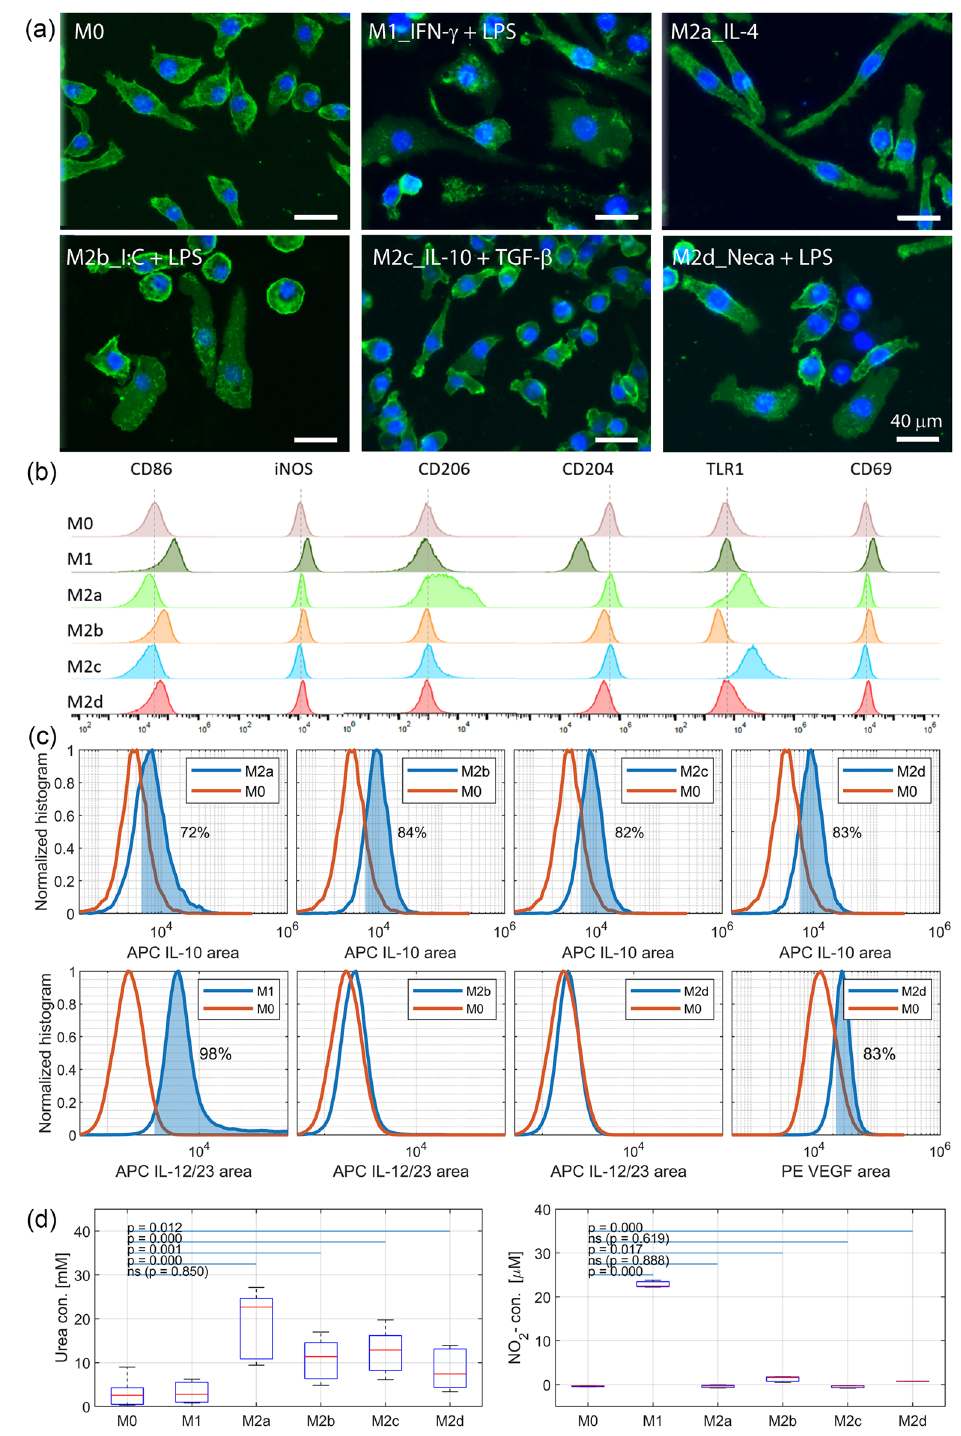
Figure 2. Unpolarized and polarized RAW264.7 macrophages displayed different morphology, expression markers, and metabolic activity. ( a ) Morphology of M0, M1, M2a, M2b, M2c and M2d macrophages with cell membrane labelled with PKH67 (green) and cell nuclei with DAPI (blue), scale bar 40 μm. ( b ) Surface and intracellular expression of CD86, iNOS, CD206, CD204, TLR1, and CD69. ( c ) IL-10, IL-12, and VEGF expression. ( d ) Arginine metabolic activity of the polarized macrophages, data are representative of three separate experiments showing the mean ± standard error of mean